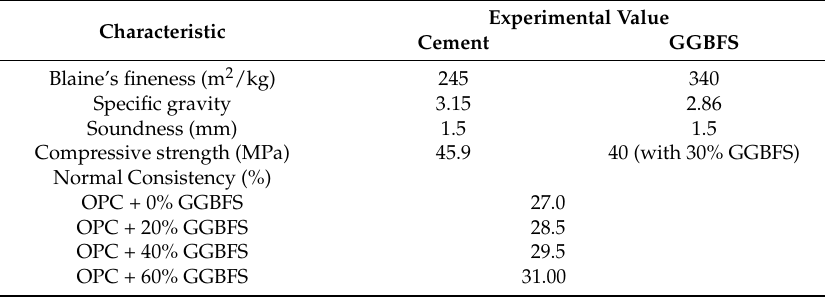
Table 1. Physical properties of the cement and ground granulated blast furnace slag (GGBFS).